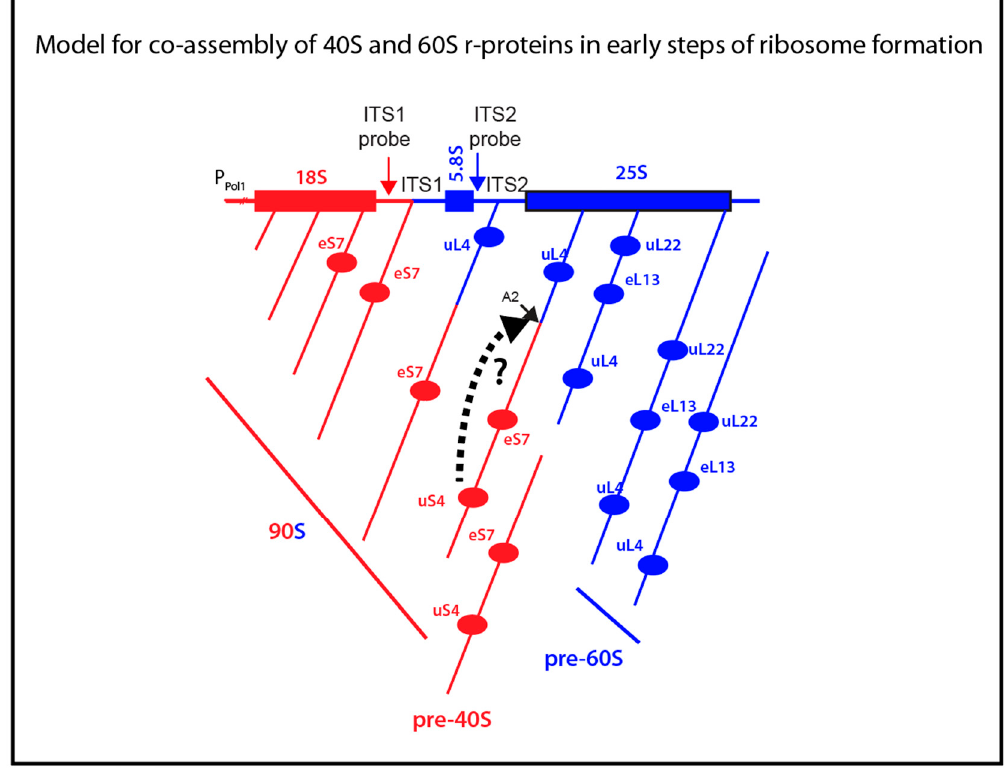
Figure 6. Model for binding of r-proteins to rRNA relative to the time of A2 cleavage separating rRNA segments destined for the small and large subunit. The horizontal map at the top illustrates the rDNA gene. The angled lines below the map illustrates growing rRNA molecules with r-proteins eS7, uS4, uL4, and eL13 binding to the rRNA during transcription. The A2 cleavage is illustrated by separation of the red 40S- and blue 60S-specific rRNA segments. The broken-line arrow from uS4 to the A2 site on the precursor illustrates the hypothesis that uS4 binding stimulates cleavage at A2. RNA and protein belonging to the 40S and 60S subunit are in red and blue, respectively. The type of particle containing the various stages of assembly is indicated below the transcript maps. 40S and 60S specific parts of the rRNA and ribosomal proteins are shown in red and blue,